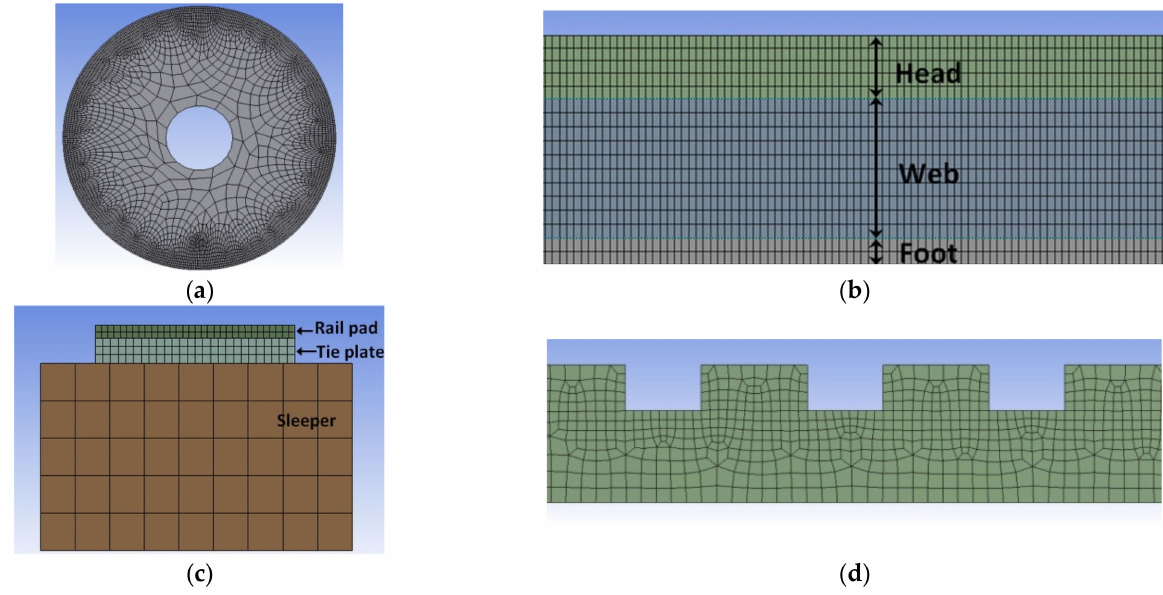
Figure 6. Mesh of: ( a ) wheel; ( b ) modeled rail 54E1 (UIC54); ( c ) rail pad, tie plate, and sleeper; ( d ) ballast layer. By decreasing the mesh size of the wheel from 6 mm to 4 mm and the rail from 5 mm to 4 mm, it was found that the results do not show a great difference, as shown in the results of the railhead stresses and wheel/rail contact